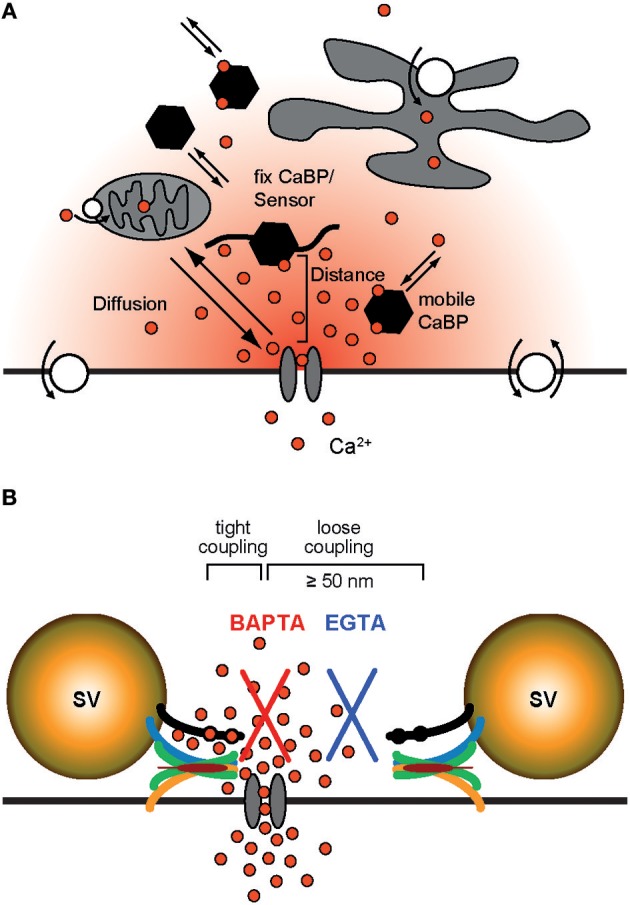
Ca2+ signaling domains. (A) General Ca2+ dynamics: Ca2+ enters a presynaptic terminal through a voltage-gated Ca2+ channel. Due to rapid diffusion (indicated by red gradient and the arrows) Ca2+ forms a steep, short-lived spatio-temporal gradient around the mouth of the open channel. It binds to mobile or fix Ca2+-binding proteins (CaBPs); some CaBP are pure buffers, others have an additional Ca2+ sensor function. Ultimately Ca2+ is cleared from the cytosol via Ca2+-ATPases (white circles with arrows) that either pump Ca2+ into the extracellular space or sequester it into organelles. (B) In a tight coupling regime a Syt bearing SV is located very close to the site of Ca2+ entry (<50 nm). If coupling is tight, at moderate concentrations only a buffer with rapid Ca2+ binding kinetics like BAPTA (red) can interfere with Ca2+ binding to Syt and prevent release. In a loose coupling regime, on the other hand, the SV is further away from the site of Ca2+ entry and also a slow buffer like EGTA (blue) can bind Ca2+ before it reaches the release sensor.